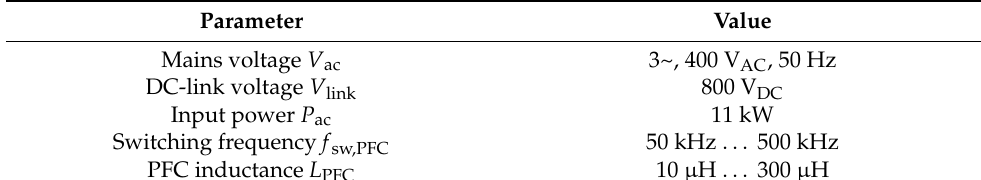
Table 3. PFC rectifier parameters used for comparison.